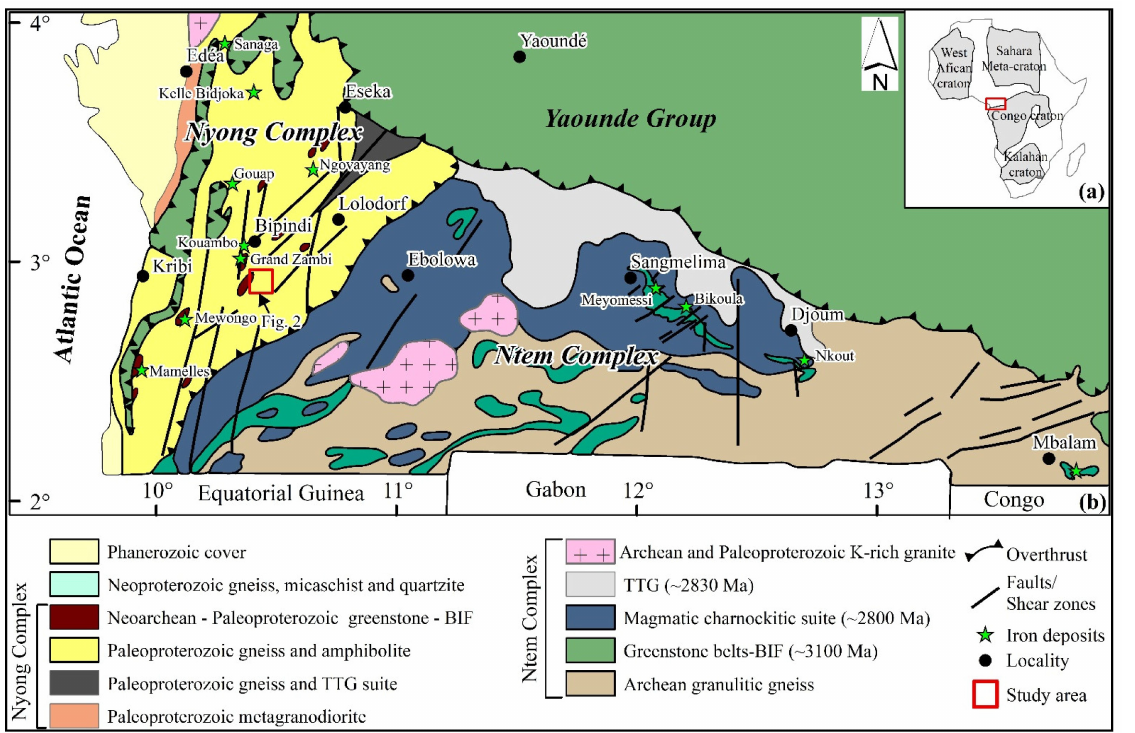
Figure 1. Sketch geological map of SW Cameroon (modified after [19], with insert showing the Congo craton in relation to other African